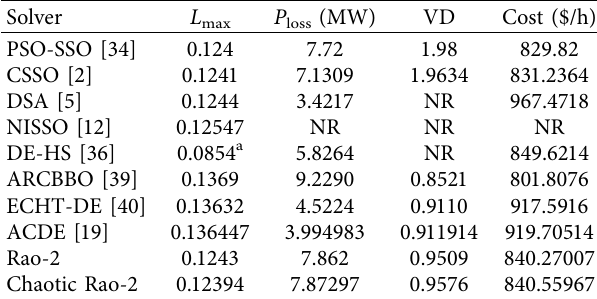
Table 5: Comparison study for case 3.